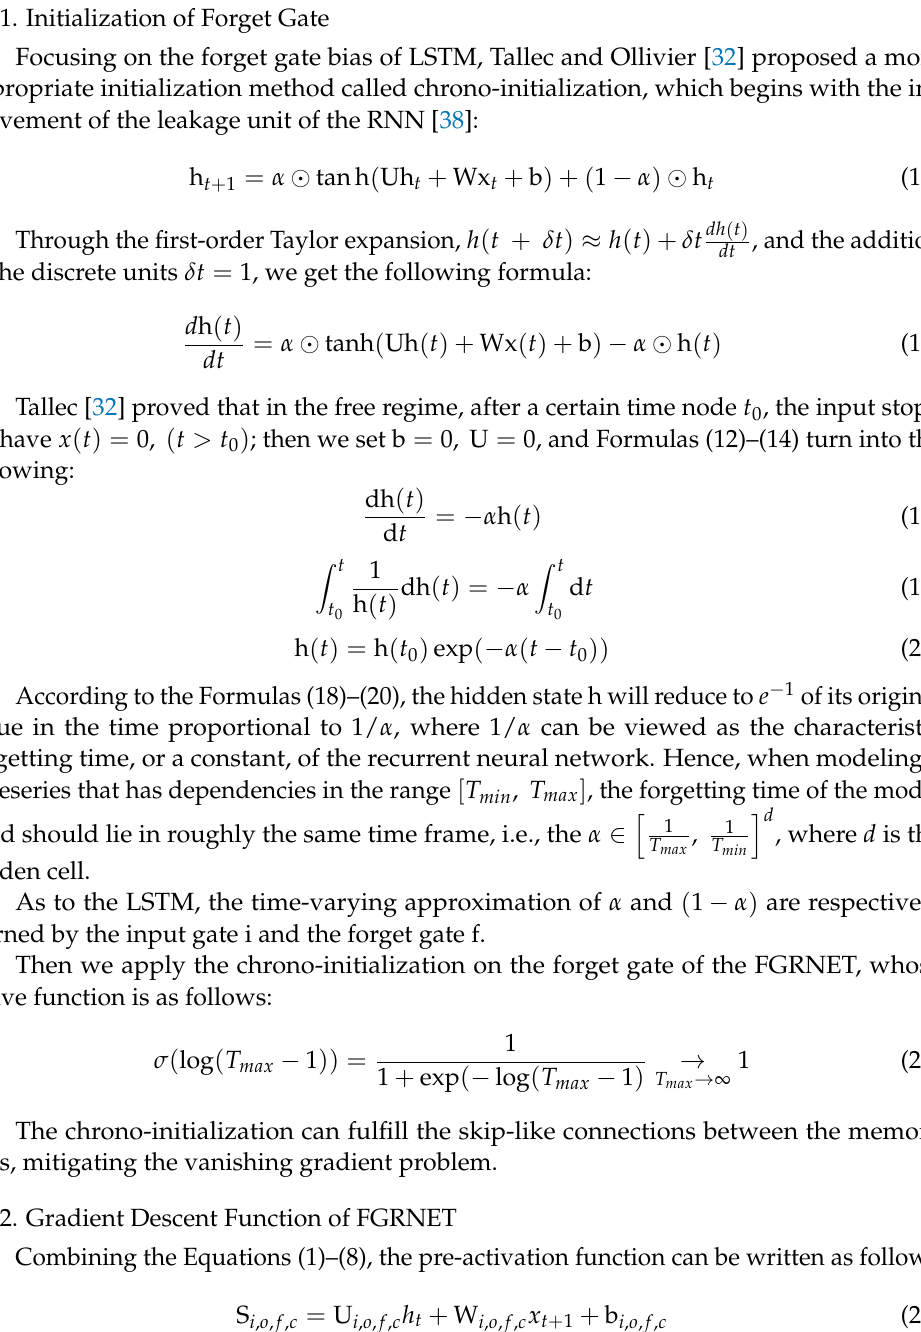
Figure 4. Forget-gate recurrent network (FGRNET) structure.